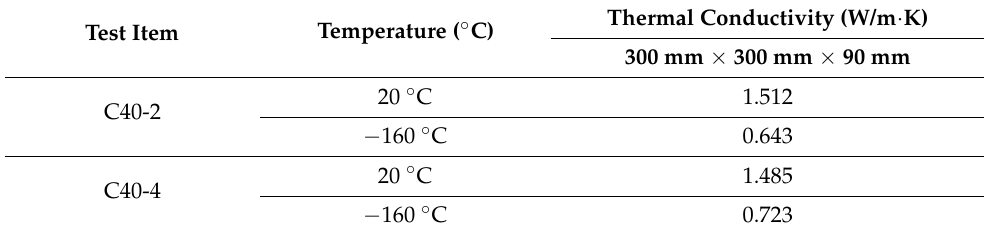
Table 13. Test results of thermal